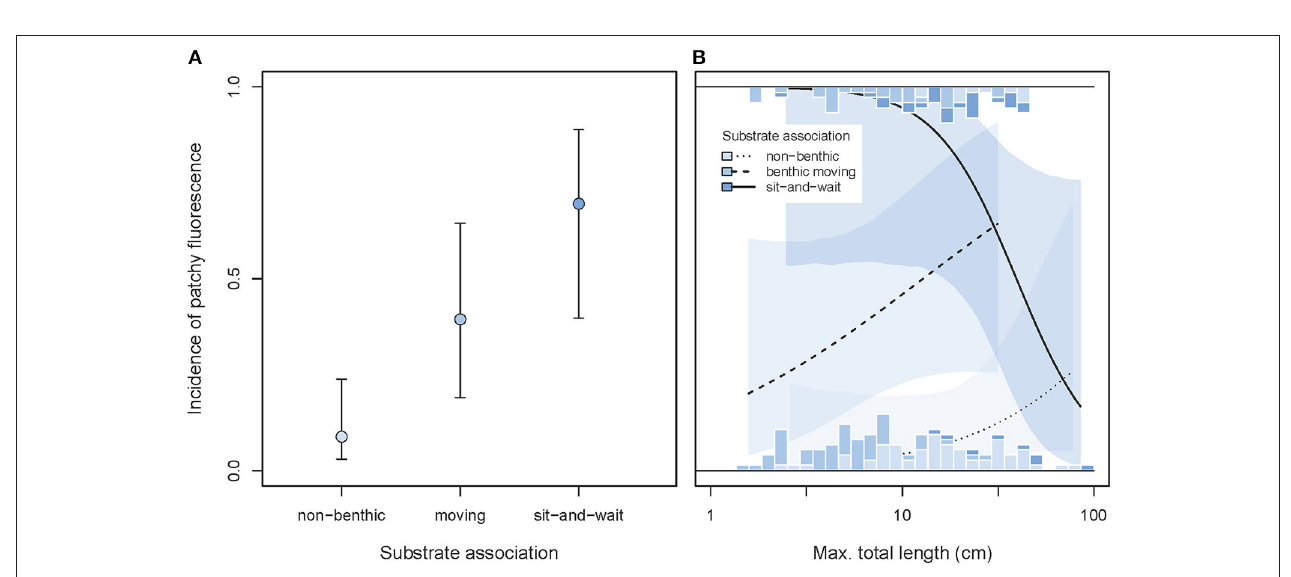
FIGURE 11 | Incidence of patchy whole body fluorescence as predicted by substrate association, maximum body length, and their interaction. (A) Shows the overall predicted incidences of patchy fluorescence ( ± 95% credibility intervals), pooling across body size. (B) Illustrates the interaction between substrate association and body size (note log 10 x -scale). Marginal stacked histograms display relative frequency distributions of raw species values. Predicted incidences (lines) and their 95% credibility intervals (shaded areas) are extracted from binomial models taking shared species ancestry into